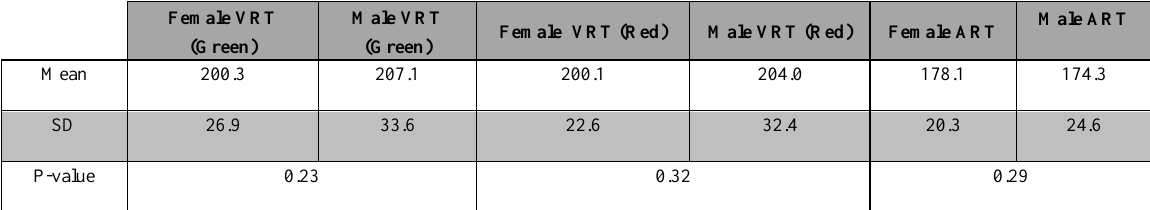
Table 4. Gender differences in auditory and visual reaction